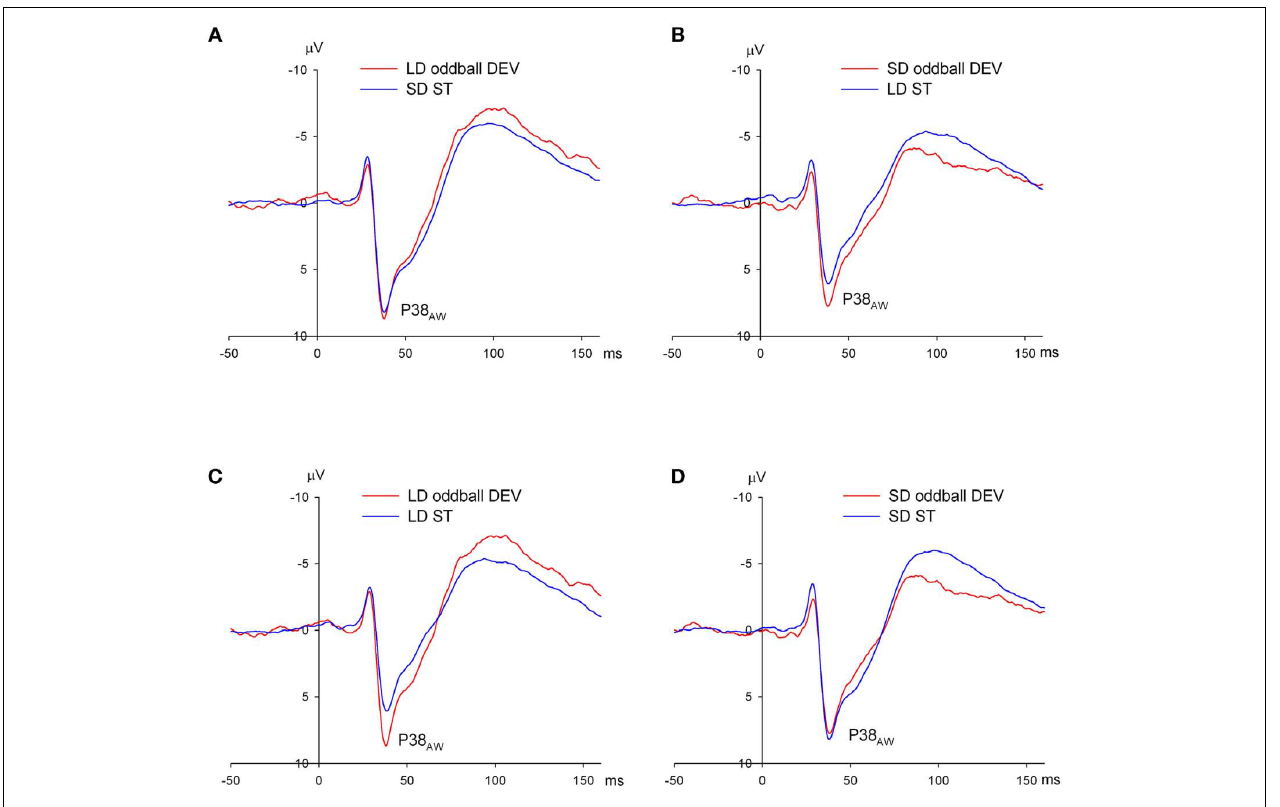
duration oddball sequence with short standards shown in (A) . (C,D) ERPs to oddball DEVs and STs in the duration oddball paradigms but controlling for stimulus duration: LD stimuli on the left (C) and SD stimuli on the right (D) . Oddball DEVs in red and STs in blue. (C,D) are equivalent to Figures 6A,C respectively without control deviants.The reduced P38 to LD STs from the descending duration oddball sequence is particularly marked in (C) , but is less marked for the SD oddball DEV from the same sequence in (D)